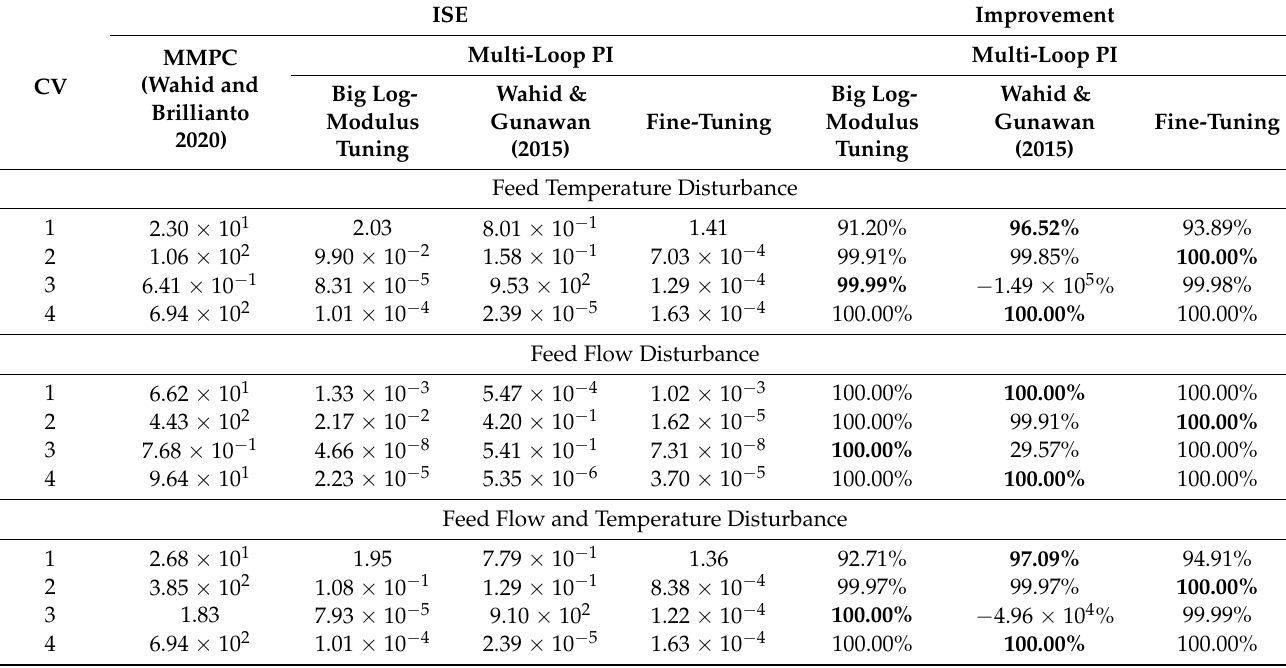
Table 11. ISE comparison of MMPC and multi-loop PI against disturbance